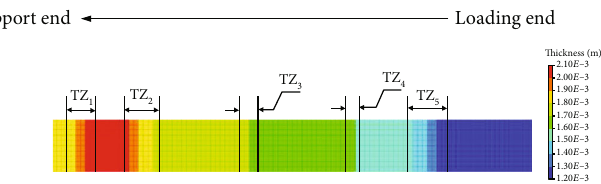
Figure 29: Thickness distribution of the TRB tube.